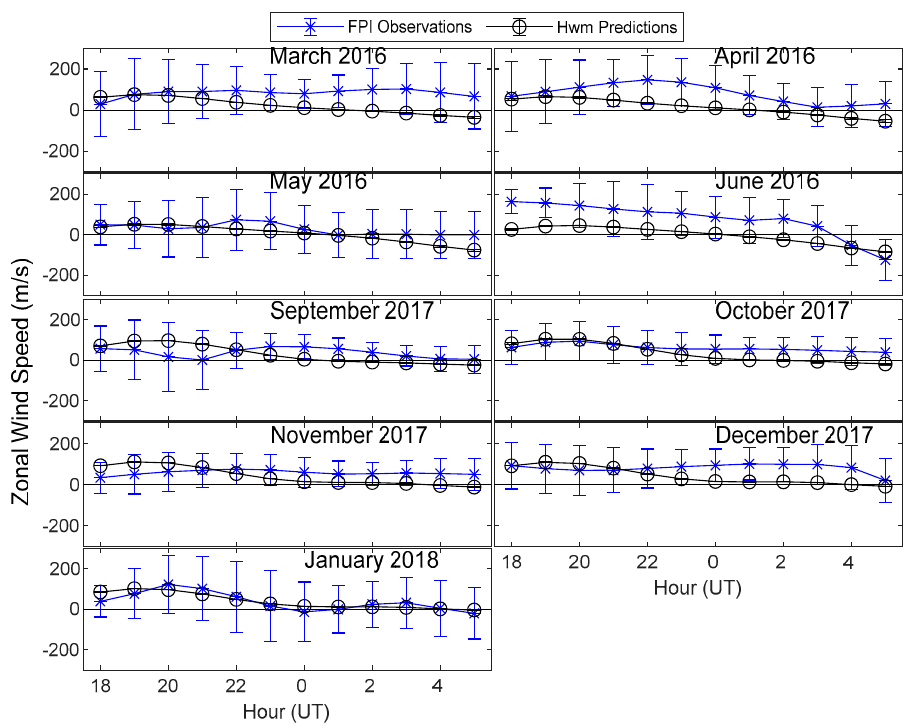
Figure 7. Zonal winds in Nigeria for March 2016 to January 2018. The blue plots represent the FPI measurements, while the black plots represent corresponding HWM-14 predictions. The vertical error bars indicate the standard deviations of the observations. Adapted with permission from Ref. [4]. 2021, Rabiu et